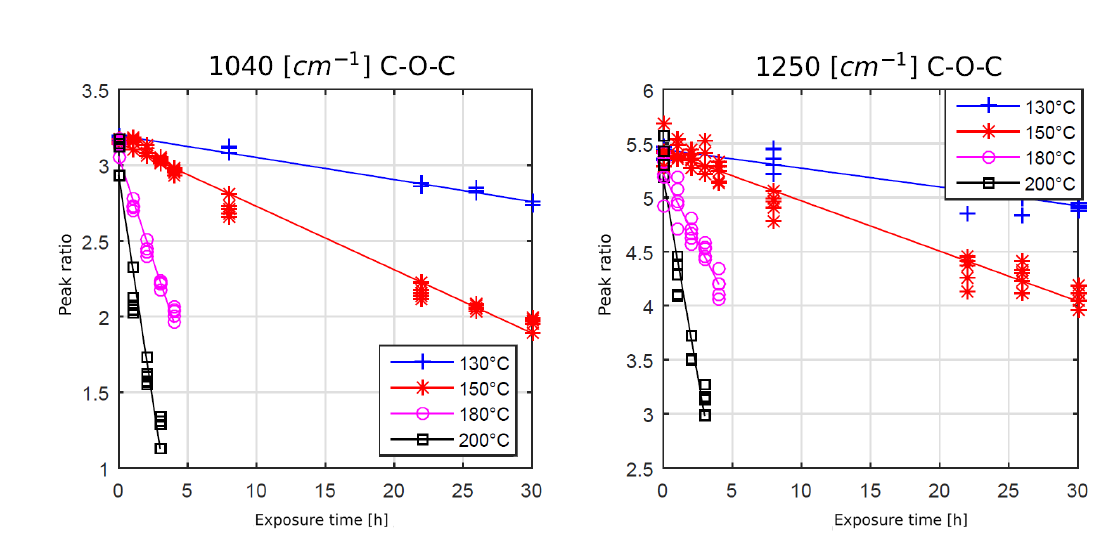
Figure 8. Development of ether bond intensities at different temperatures and times, each approximated by a linear regression